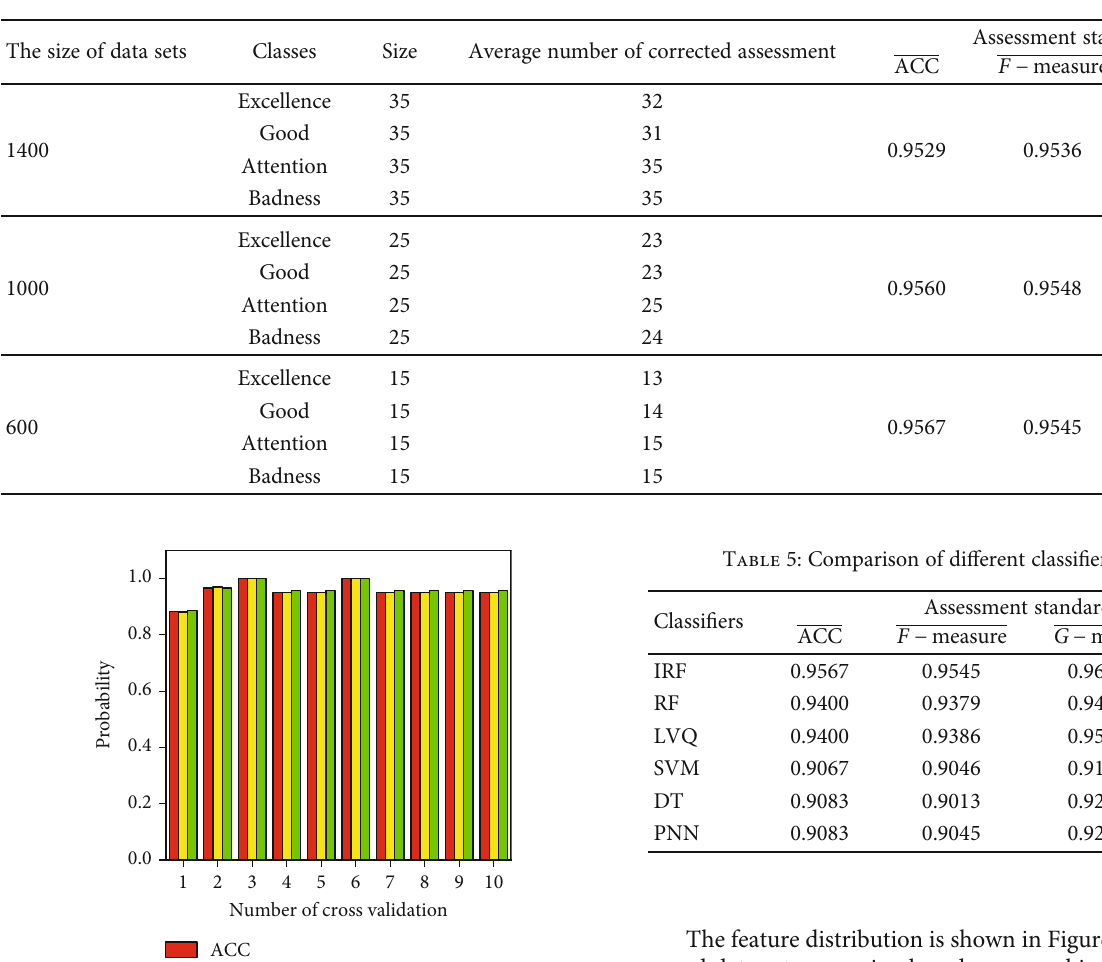
Figure 5: The temperature of features in wind turbine generator. Table 4: The assessment results of IRF based on di ff erent sizes of data sets.